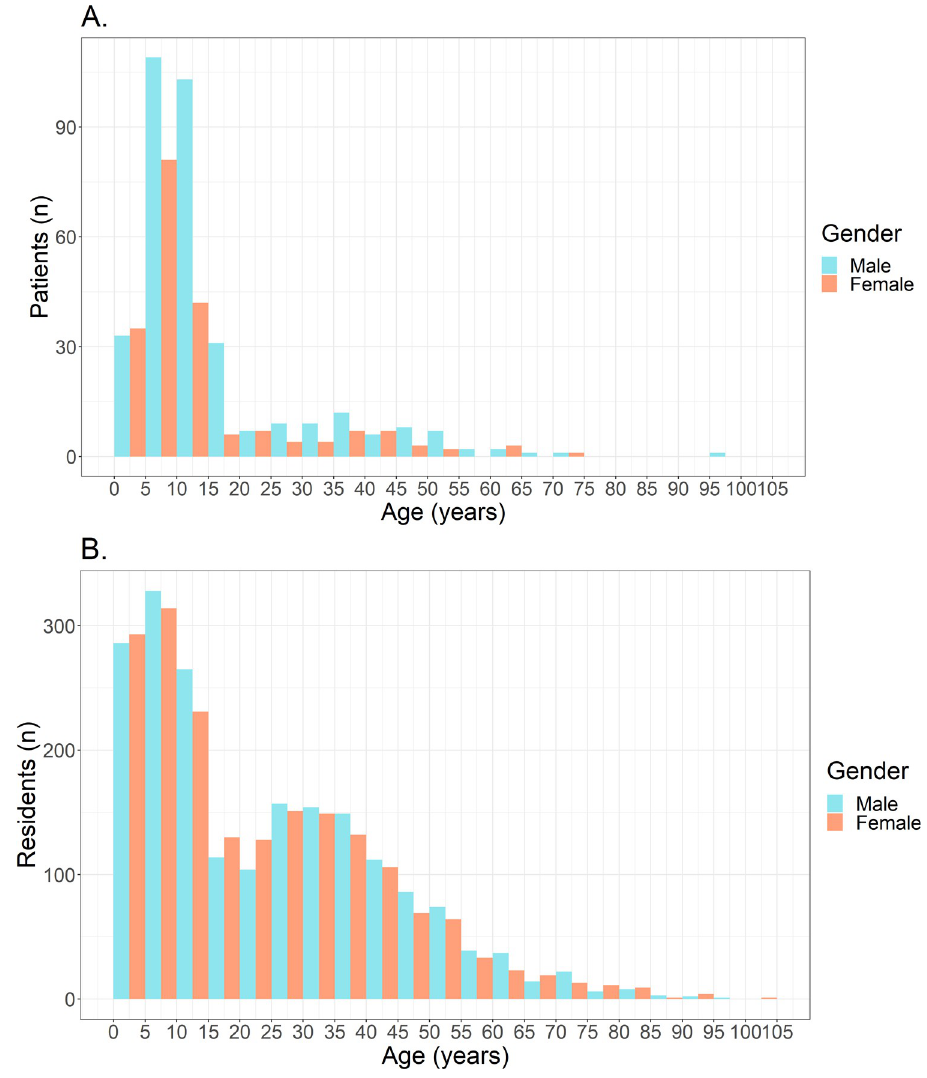
Fig 5. Age distribution by gender of the patient population (A) and of the Ahondo Health Area population